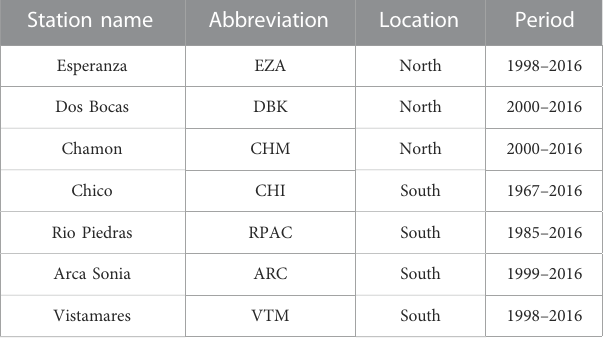
TABLE 1 List of rain gauge stations and data periods used in this study. The location column shows whether the area is located north or south of 9.3 ° N. Station name